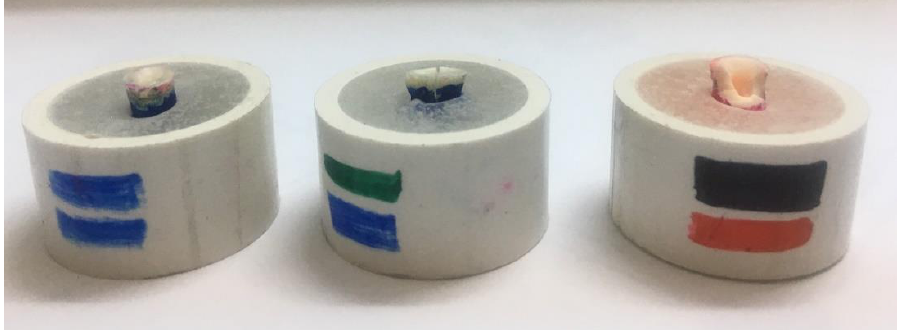
Figure 2. Fracture resistance evaluation with a universal testing machine.